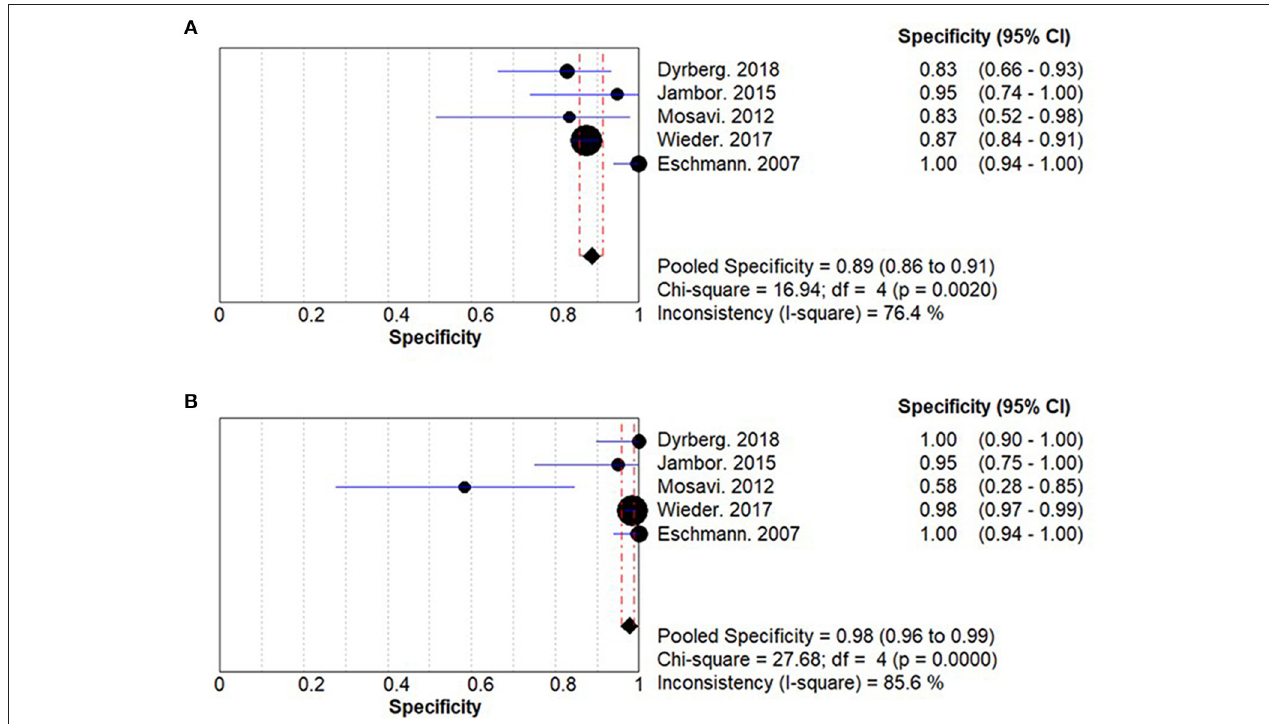
FIGURE 3 | Summary results for specificity in whole-body magnetic resonance imaging (WBMRI) (A) and positron emission tomography/computed tomography (PET/CT) (B)